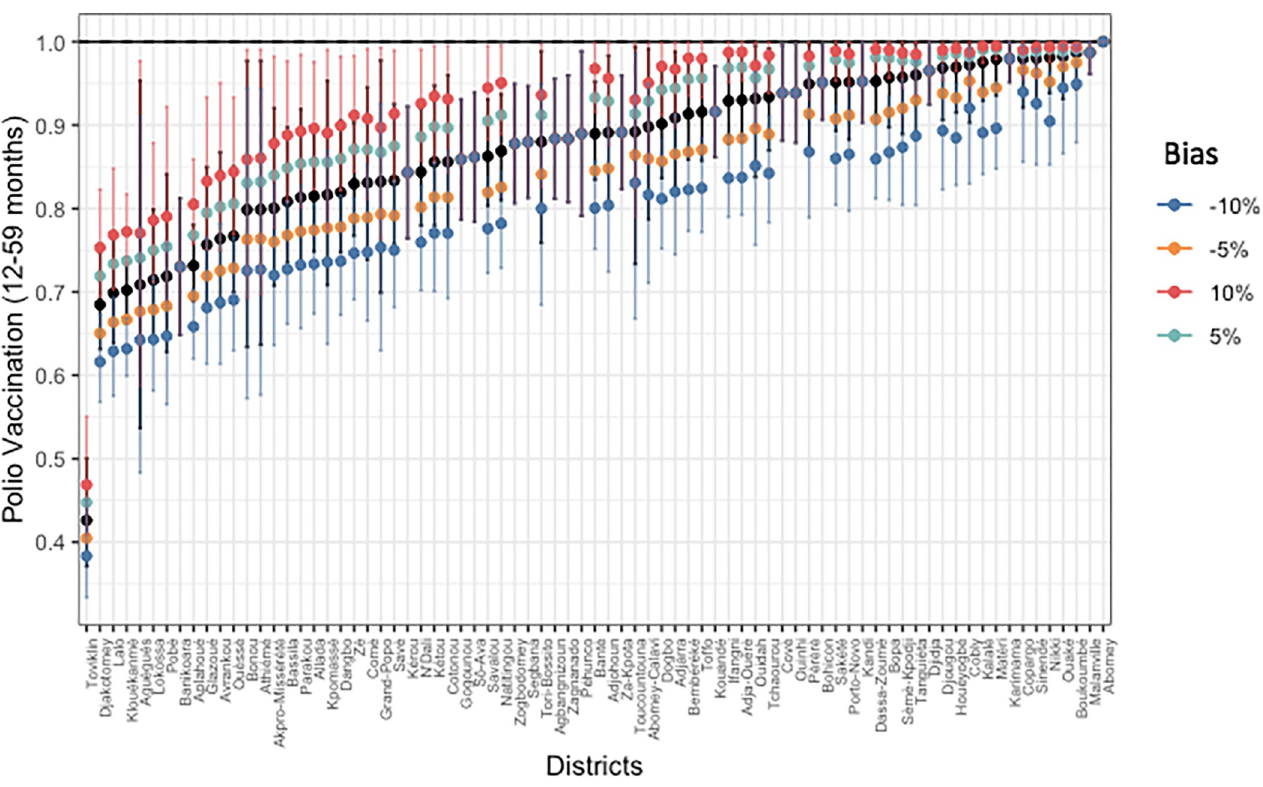
Fig 4. Sensitivity analysis of polio vaccination rates by